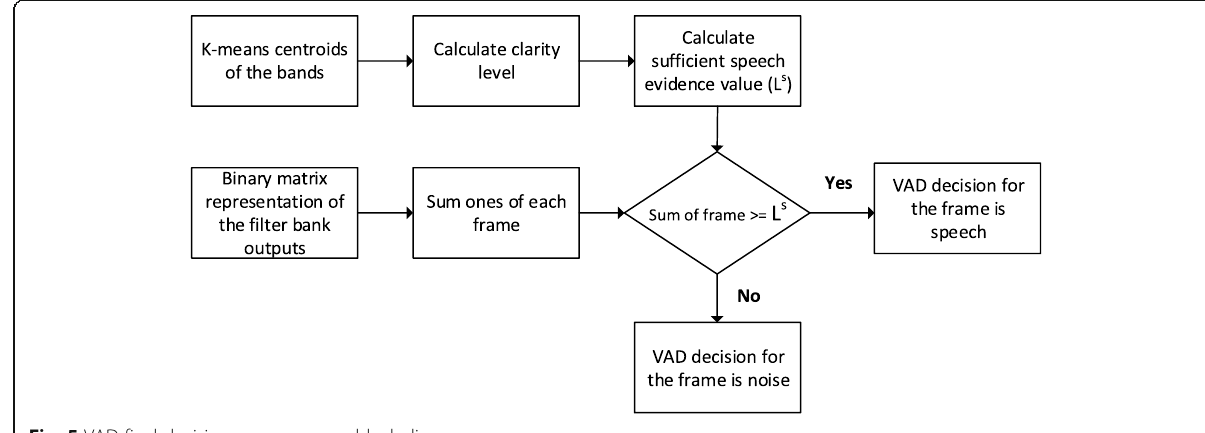
Fig. 5 VAD final decision processes as a block